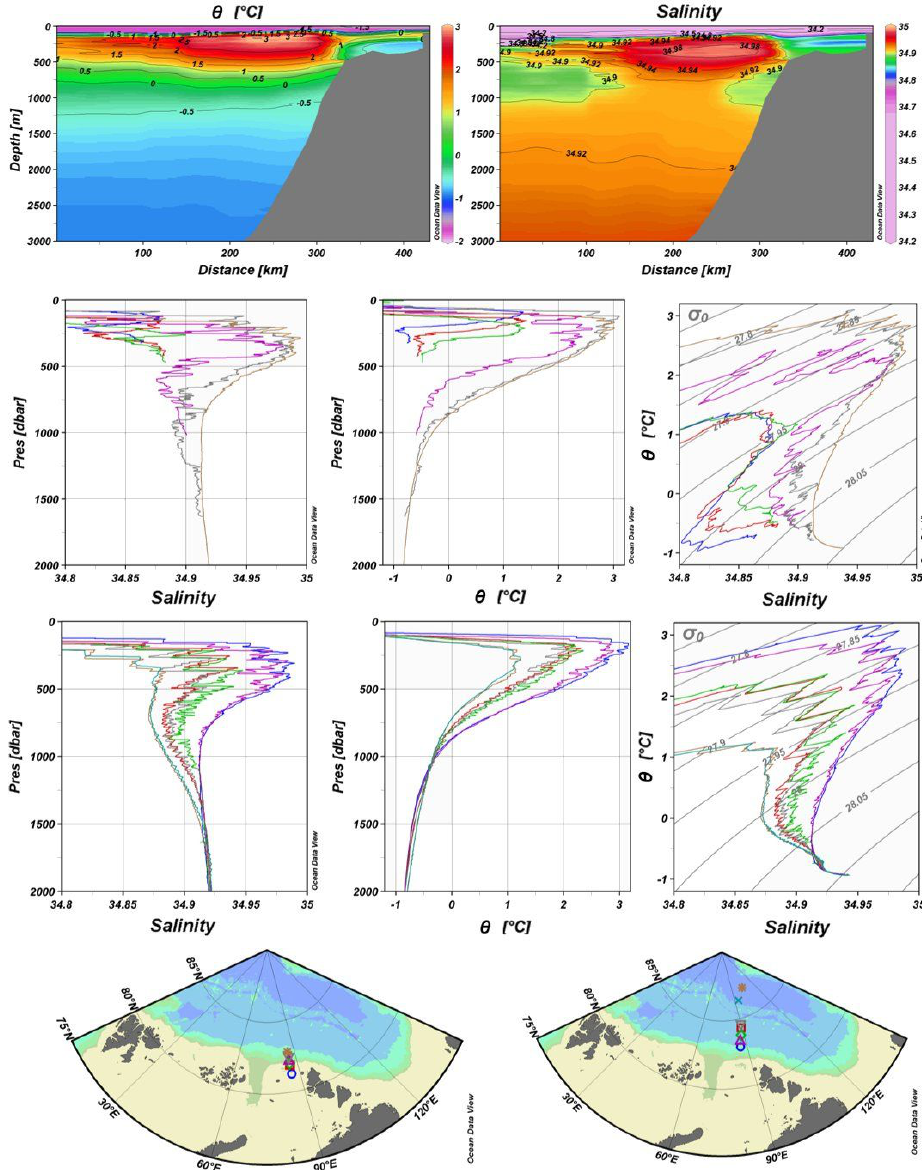
Fig. 12. Water masses mixing and interleaving in the Nansen Basin north of the eastern Kara Sea. Upper panel: temperature and salinity sections from the shelf to the Gakkel Ridge showing the warm saline Fram Strait Atlantic core and the cooler and less saline Barents Sea branch water on the slope and also on the basin side of the warm core. Upper centre panel: potential temperature and salinity profiles and θS curves from the slope showing the characteristics of the two branches and the mixing between them across the front. Lower centre panel: potential temperature and salinity profiles and θS curves from the deep basin showing the interleaving structures and different fronts. Lower panel: maps showing the positions of the stations. Data from Polarstern